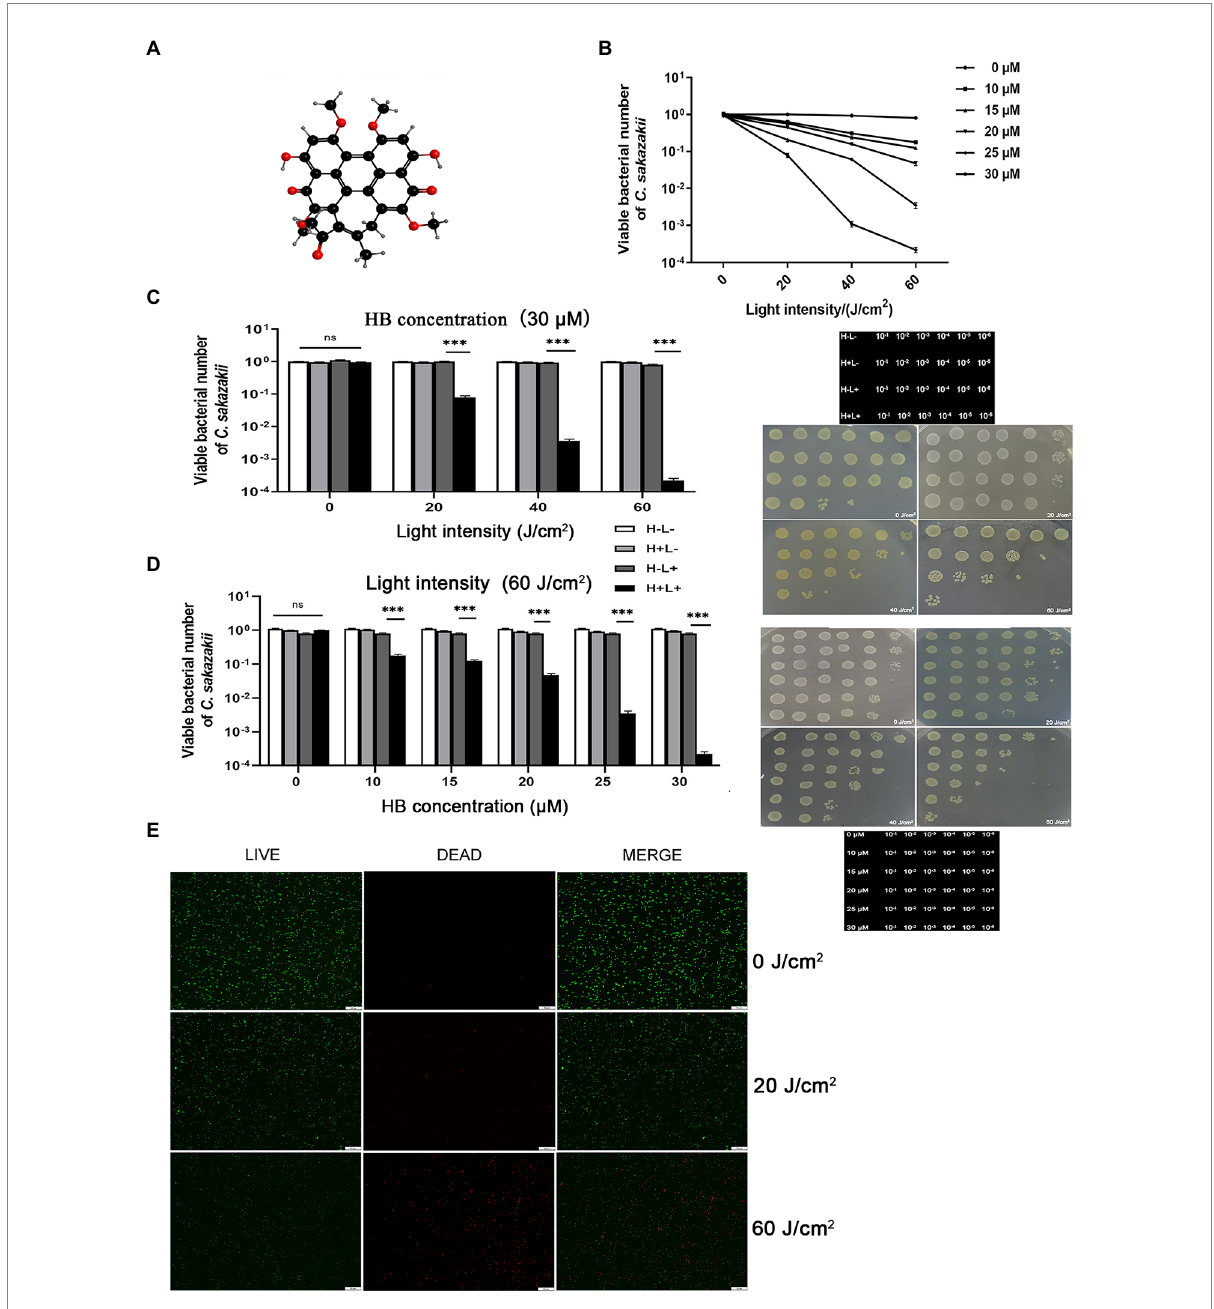
FIGURE 1 Inhibitory activity of antimicrobial photodynamic inactivation on Cronobacter sakazakii . The aPDI based on hypocrellin B (A) was used to control the growth of C. sakazakii ATCC29544. The survival rate (B) of this strain was calculated relative to the dark control, according to the plate counting data. The photodynamic conditions were set as 10, 15, 20, 25, 30 μ M for HB, and 20, 40, 60 J/cm 2 for light intensity, respectively. The influence of light intensity (C) and HB concentration (D) on the bacterial survival were then plotted in bar charts, whereas three control groups (blank, light only and HB only) were designed to fully indicate the aPDI effect. The representative dot plating graphs as well as the layout on the medium plate were also shown. In (C), 30 μ M HB was used, and in (D) , 60 J/cm 2 light was used. To validate this effect, the LIVE/DEAD double staining was carried out (E) , and green (live), red (dead) and merged images were obtained from fluorescence microscopy. This assay was performed in cells treated with 30 μ M HB. The scale bar represents 50 μ m. H-L-, blank control; H+L-, single HB-treated group; H-L+, single light-treated group; H+L+, the aPDI-treated group. Values are the mean ± SEM (standard error of mean) from 6 replicates. * p < 0.05, ** p < 0.01, *** p <